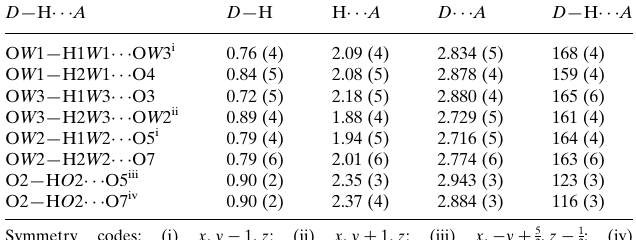
Data collection 11267 measured reflections Oxford Diffraction Xcalibur 6245 independent reflections Sapphire3 diffractometer Absorption correction: multi-scan ( CrysAlis PRO ; Oxford Diffrac- tion, 2010) T min = 0.760, T max = 0.810 Hydrogen-bond geometry (A˚ , (cid:3) ). D —H (cid:2)(cid:2)(cid:2)